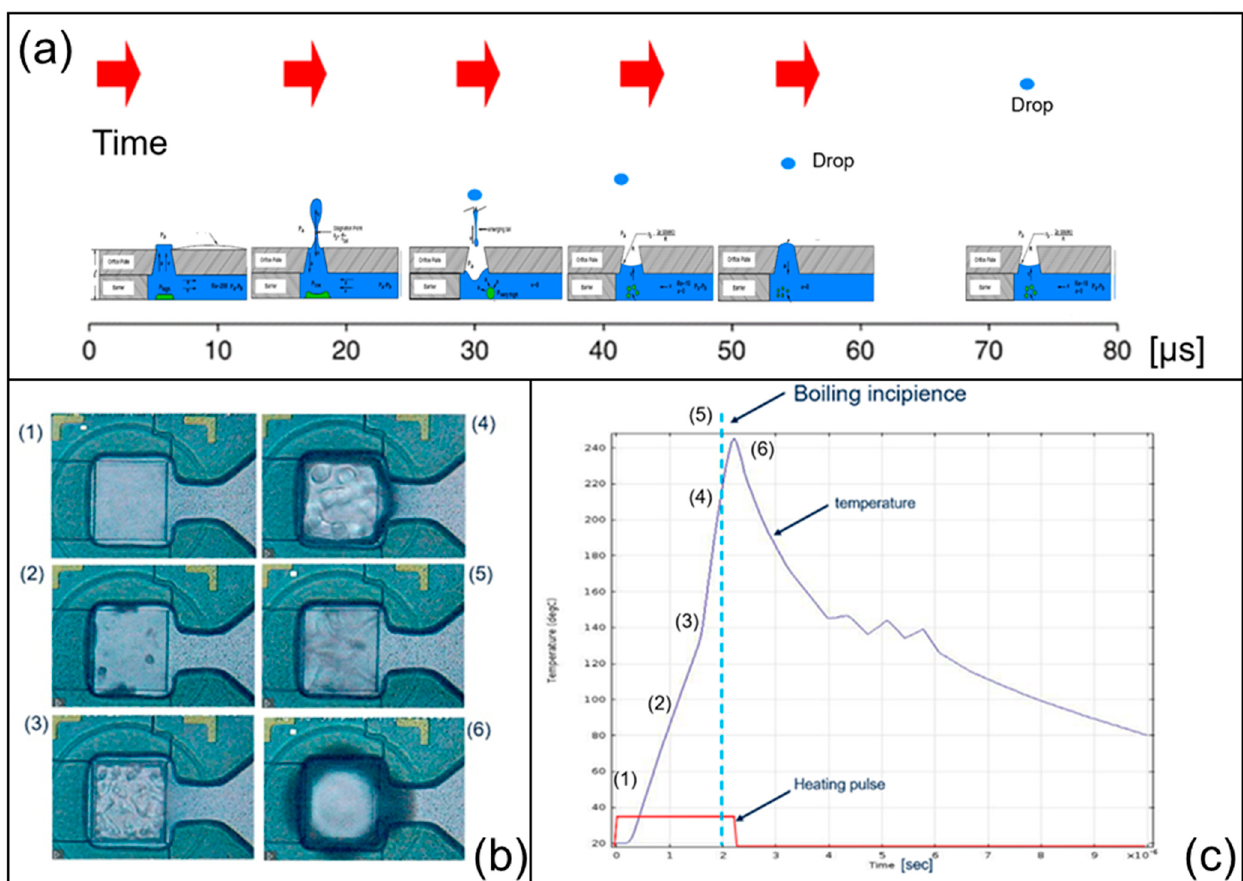
Figure 1. ( b ) thin-film heater with dimensions of 50 × 50 µ m made of TaSin. Pulse power Q = 15 W, pulse width τ = 2.5 µ s, turn on energy TOE = 0.0000375 J. The temporal evolution with bubble growth is presented ( a ). Thermal ink-jet jetting mechanism in relation with pulse heating ( b ), temperature, pressure, and bubble volume ( c ).